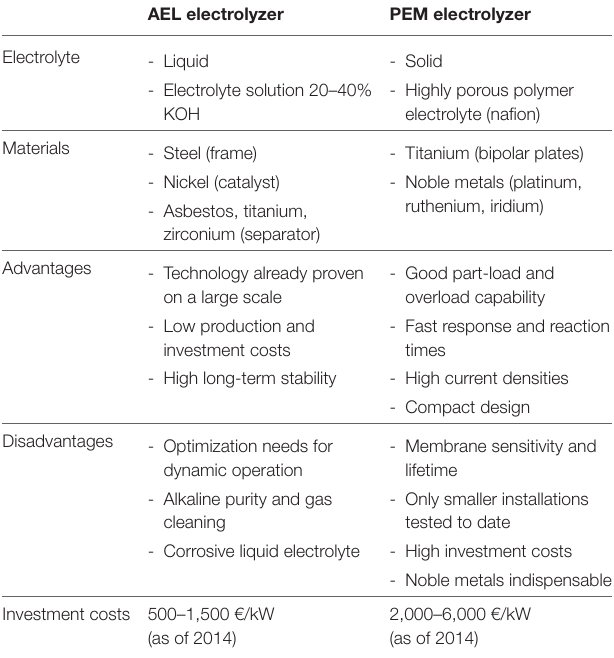
TaBle 2 | Comparison of AEL and PEM (Schiller, 2012; Carmo et al., 2013; Zapf,